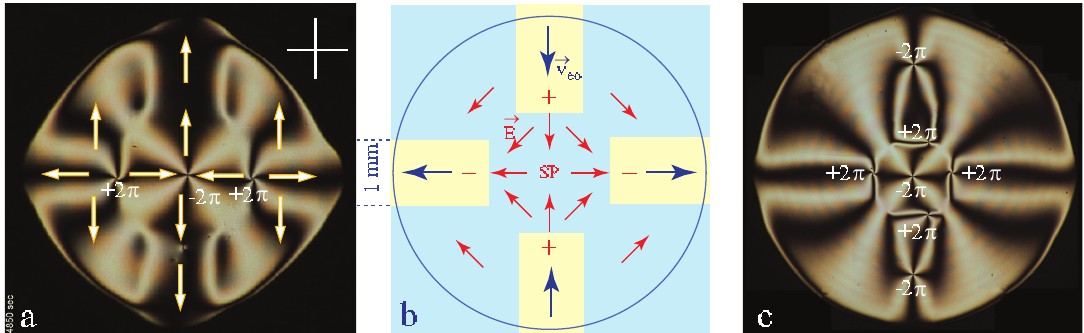
osmotic flows which in MBBA are parallel to the electric field.